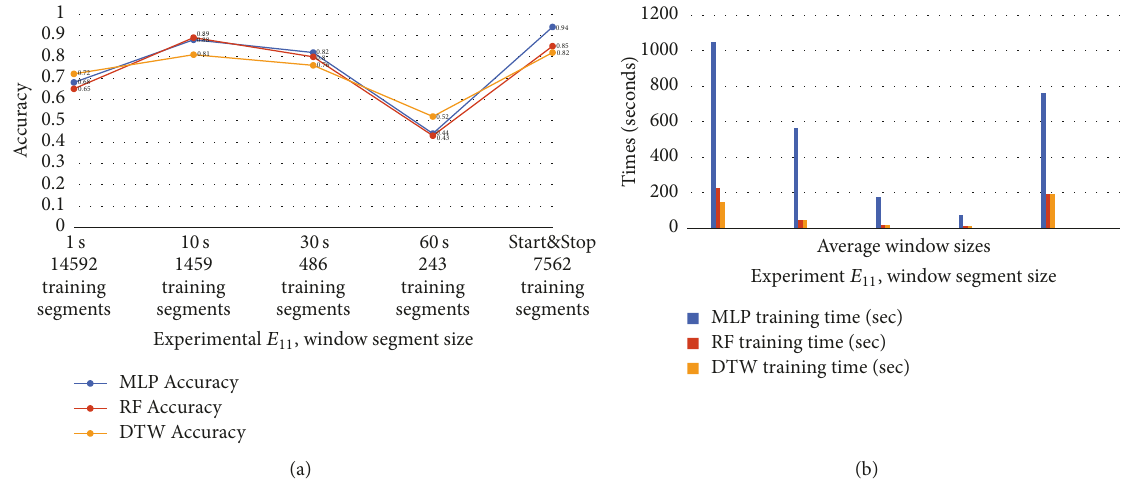
Figure 5: 𝐸 11 , trend of accuracy (a) and training times (b) evaluated by using MLP, RF, and DTW classifiers for different windows sizes.